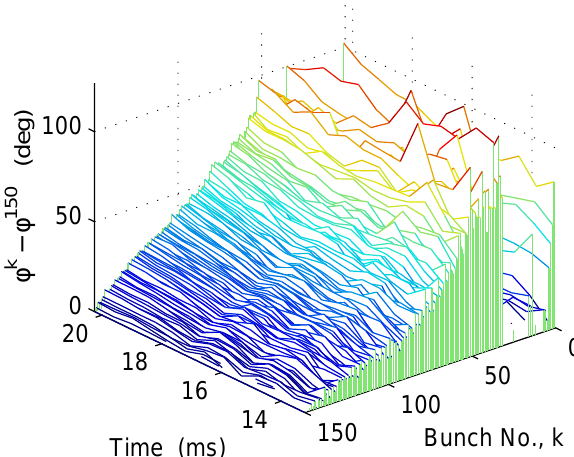
(cid:3) for 2 f 150 n n